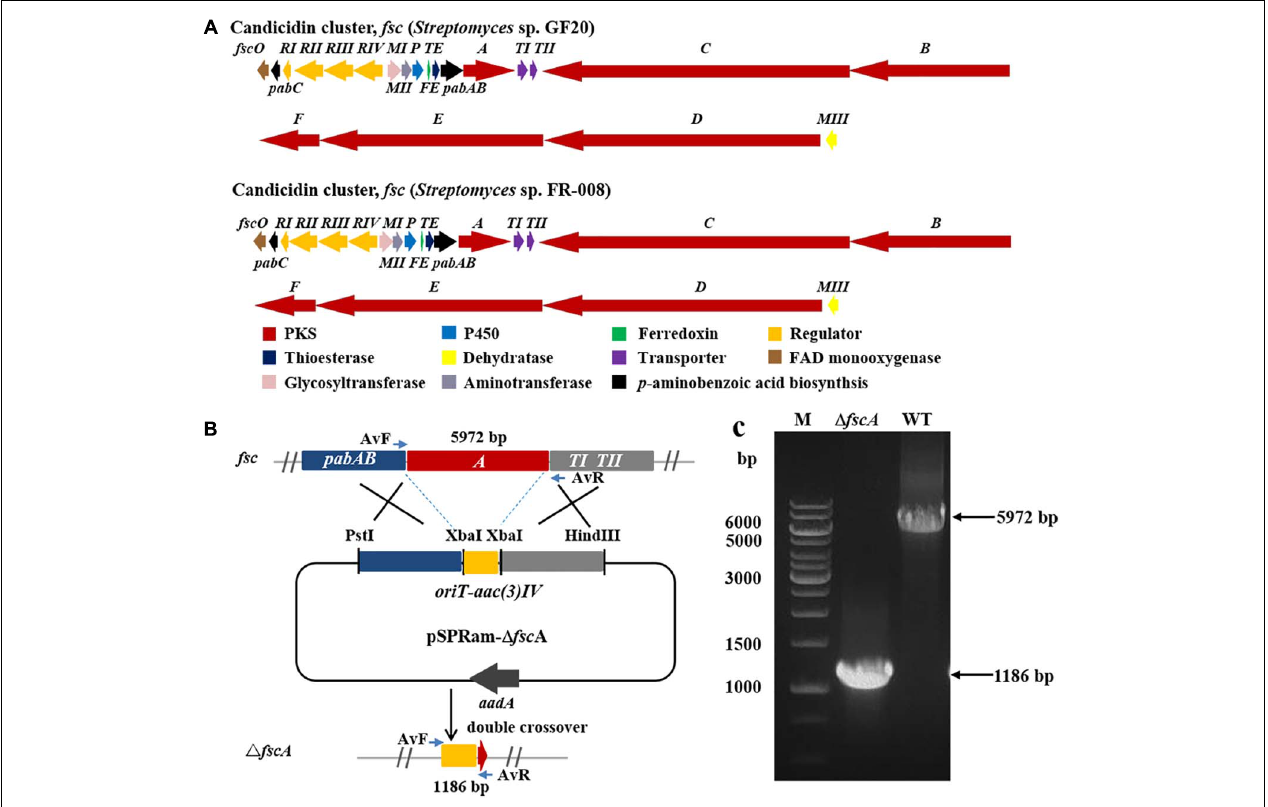
FIGURE 5 | Disruption of candicidin biosynthetic gene fscA in Streptomyces sp. GF20. (A) Comparison of the genetic organization of candicidin BGCs in Streptomyces sp. GF20 and Streptomyces sp. FR-008. (B) Schematic representation for disruption of fscA in Streptomyces sp. GF20. (C) Verification of the fscA -disrupted mutant by PCR. M, DNA size marker. The fragments were amplified using primers of